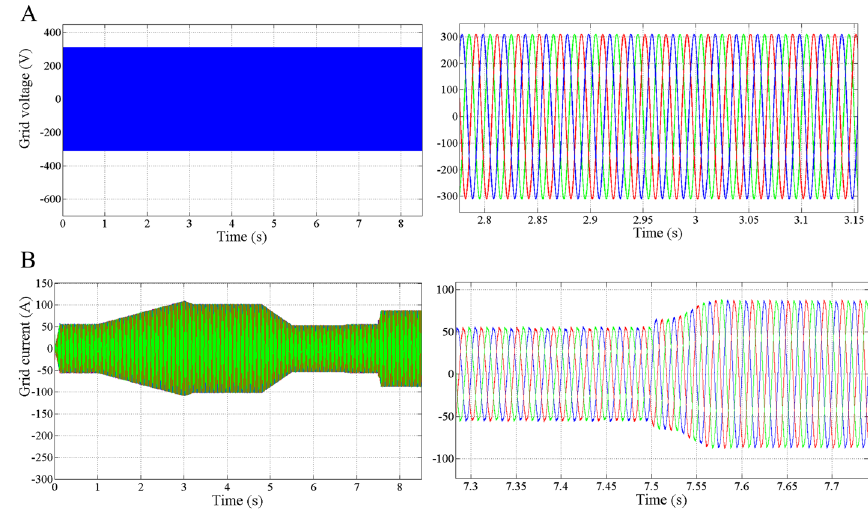
Fig. 14 a Voltage injected to the grid. b Current injected to the